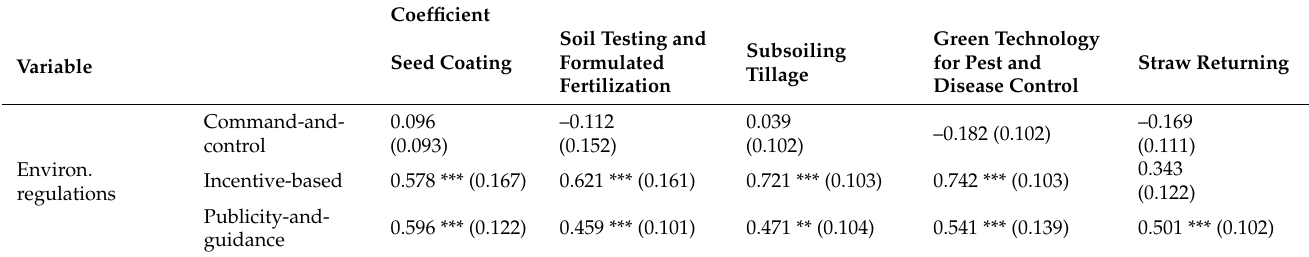
Table A2. Regression results of multivariate probit model (model